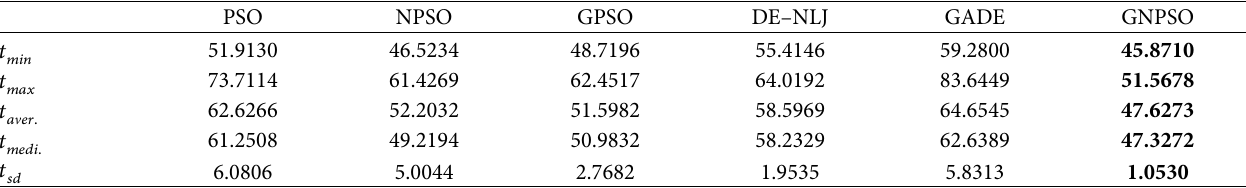
Table 20: Statistical results of computation time (sec) using different algorithms for Case 3: MIMO nonlinear wing vibration system with two control surfaces